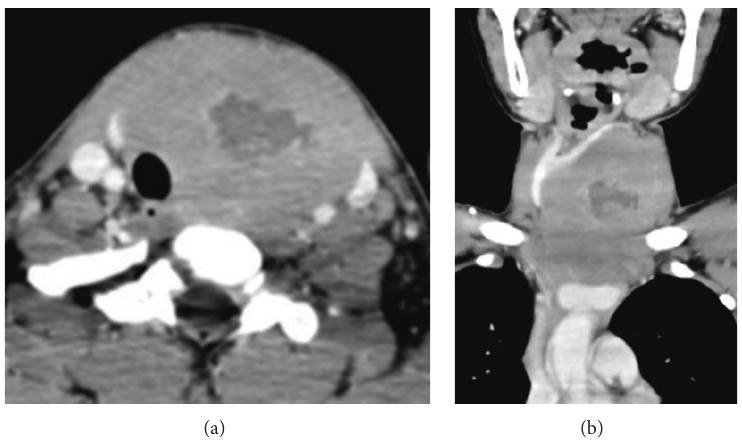
Figure 4: Axial (a) and coronal (b) CT scan showing the thyroid tumor larger than a month before (Figure